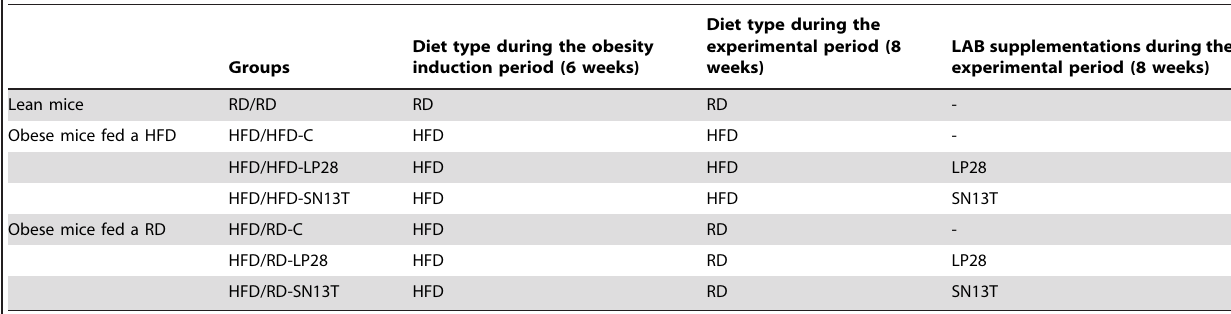
Table 2. Experimental